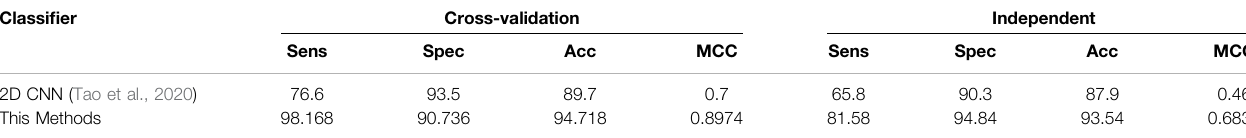
TABLE 5 | Comparison with the experimental results of 2D CNN in the same